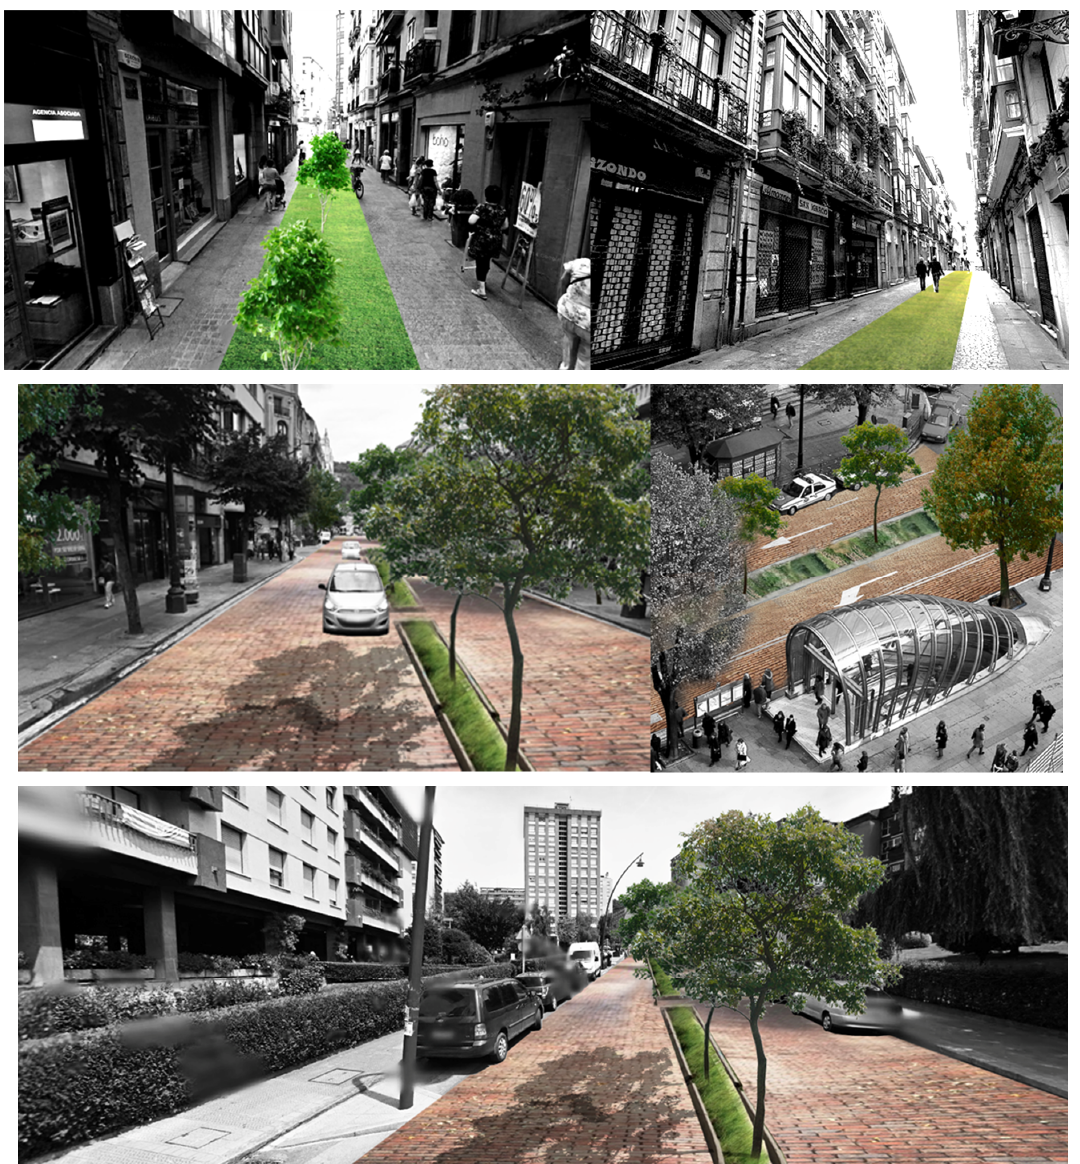
Figure 17. Visualizations of potential green intervention in compact low-rise Casco Viejo (top), compact mid-rise Abando / Indautxu (middle) and open-set high-rise Txurdinaga / Miribilla (bottom) urban areas of Bilbao. Elaboration from Google Street views.